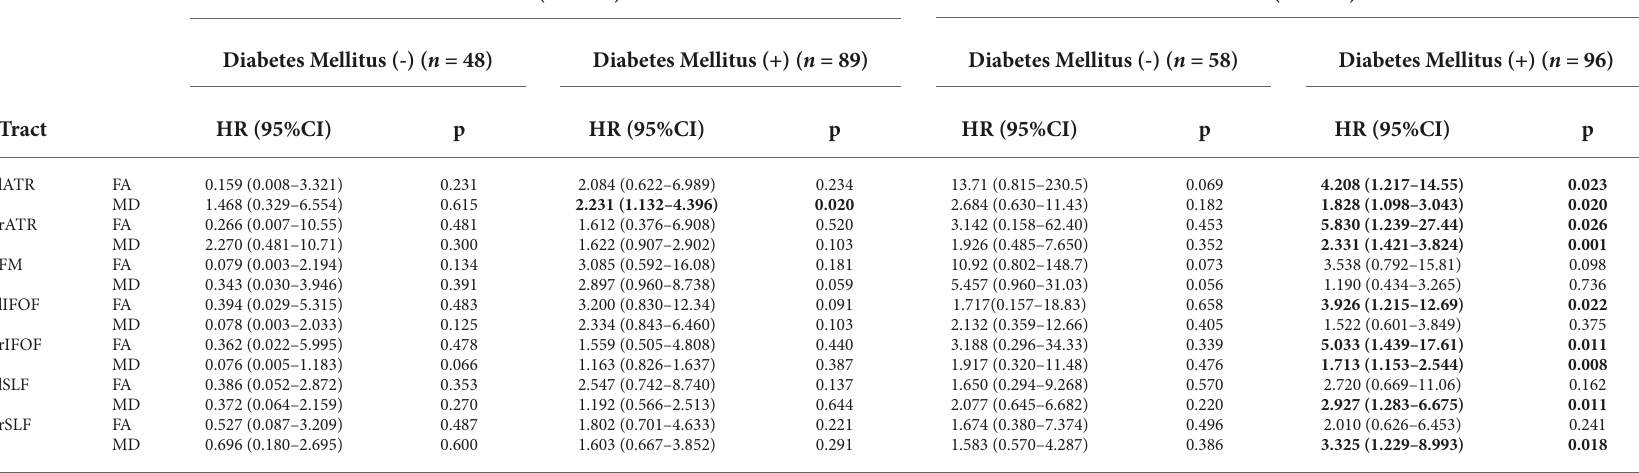
TABLE 4 Cox regression analysis of the DTI values for the incidence of frailty stratified according to diabetes mellitus status. mCHS ( n =